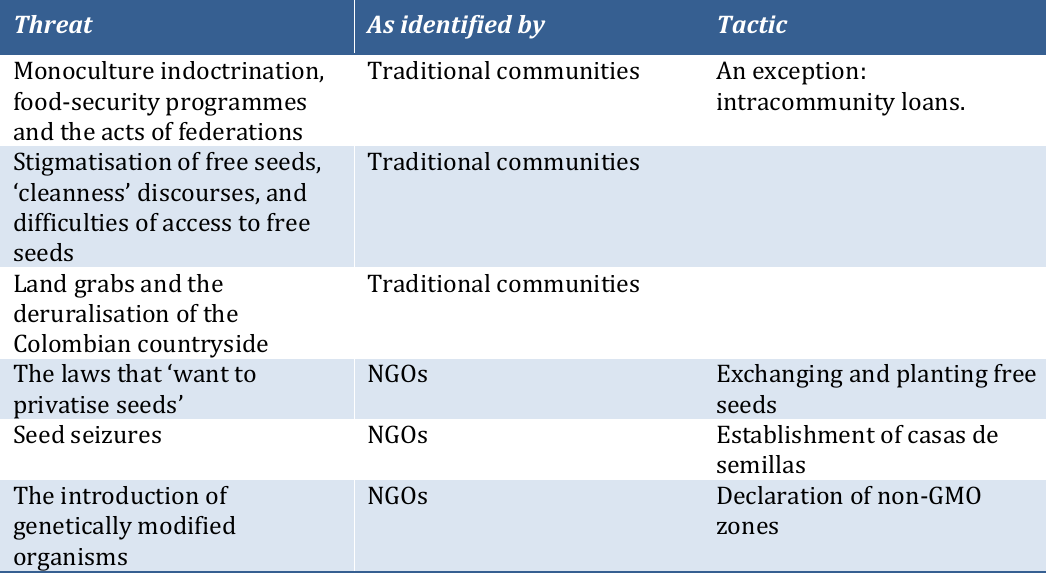
Table 1: Diagnostic and